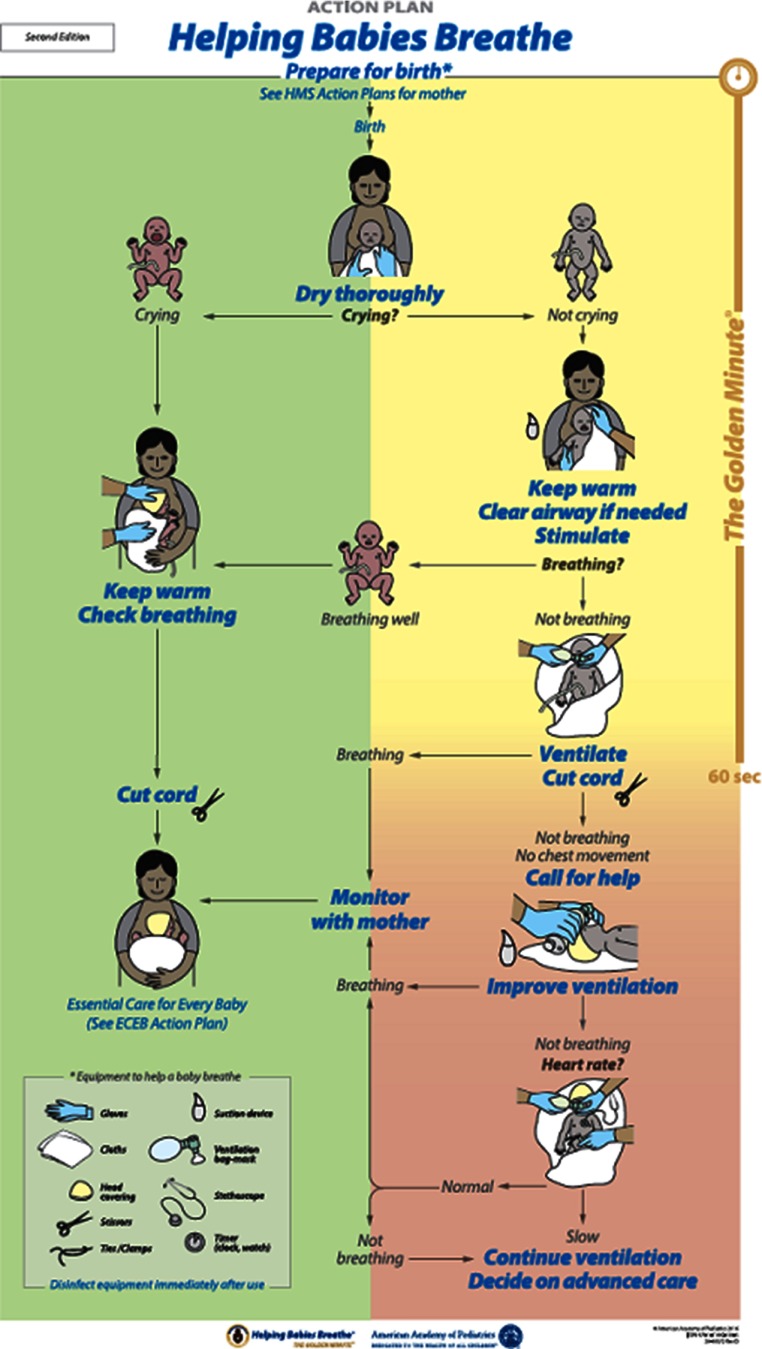
Helping Babies Breathe Second Edition Action PlanAbbreviations: ECEB, Essential Care for Every Baby; HMS, Helping Mothers Survive.Source: Niermeyer S, Kamath-Rayne B, Keenan W, Little G, Singhal N, Visick M, eds. (2016).7 Reprinted with permission from the American Academy of Pediatrics.